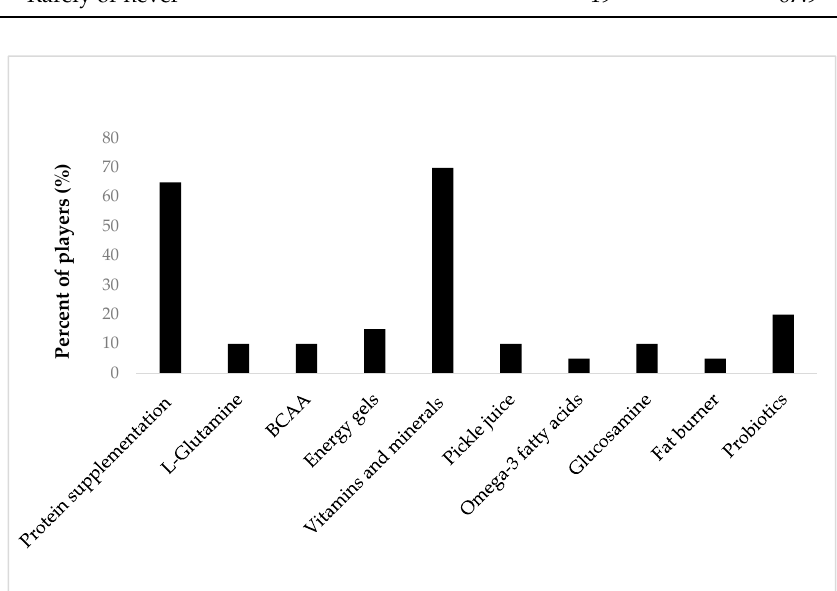
Figure 1. Current supplement use in VFLW players (n = 30). BCAA: branched-chain amino acids